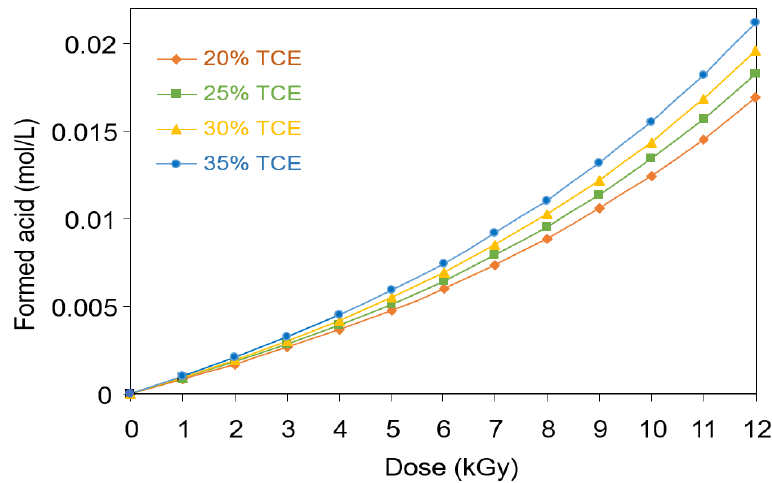
Figure 3. Concentration of acid formed as function of dose in PVA-TCE-CR polymer films with different compositions of TCE derived from the absorbance at 438 nm.